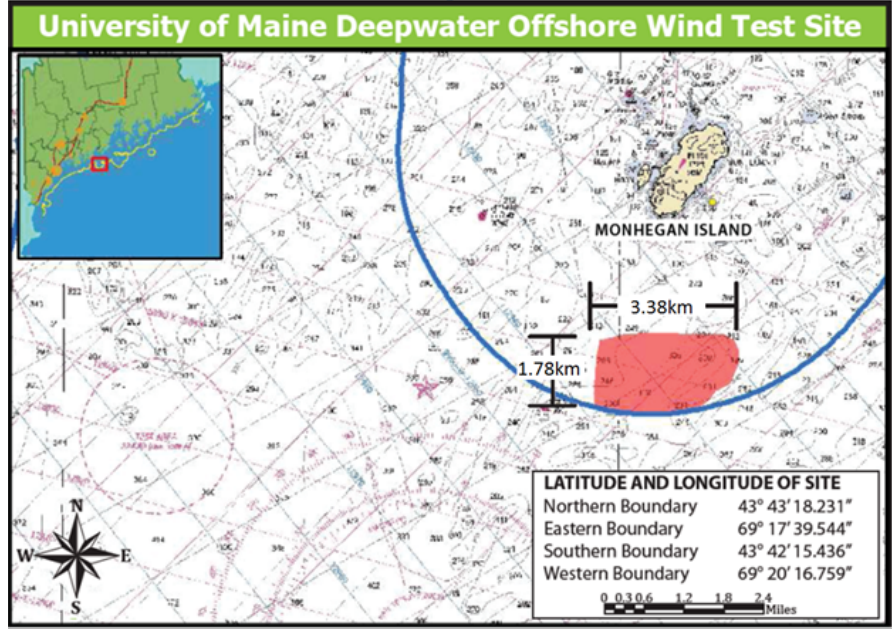
Figure 14. Map of the project site’s